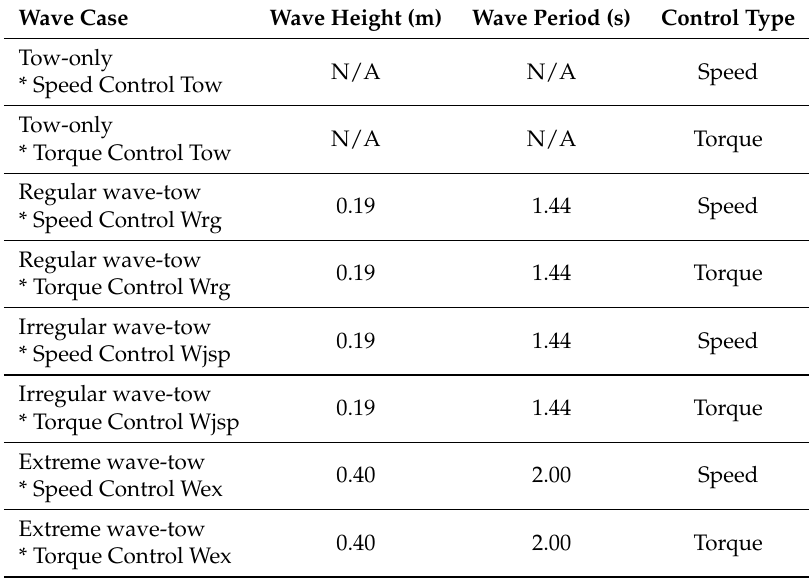
Table 2. Test matrix showing the wave cases and control type used throughout the test campaign. All tests were run at 1.0